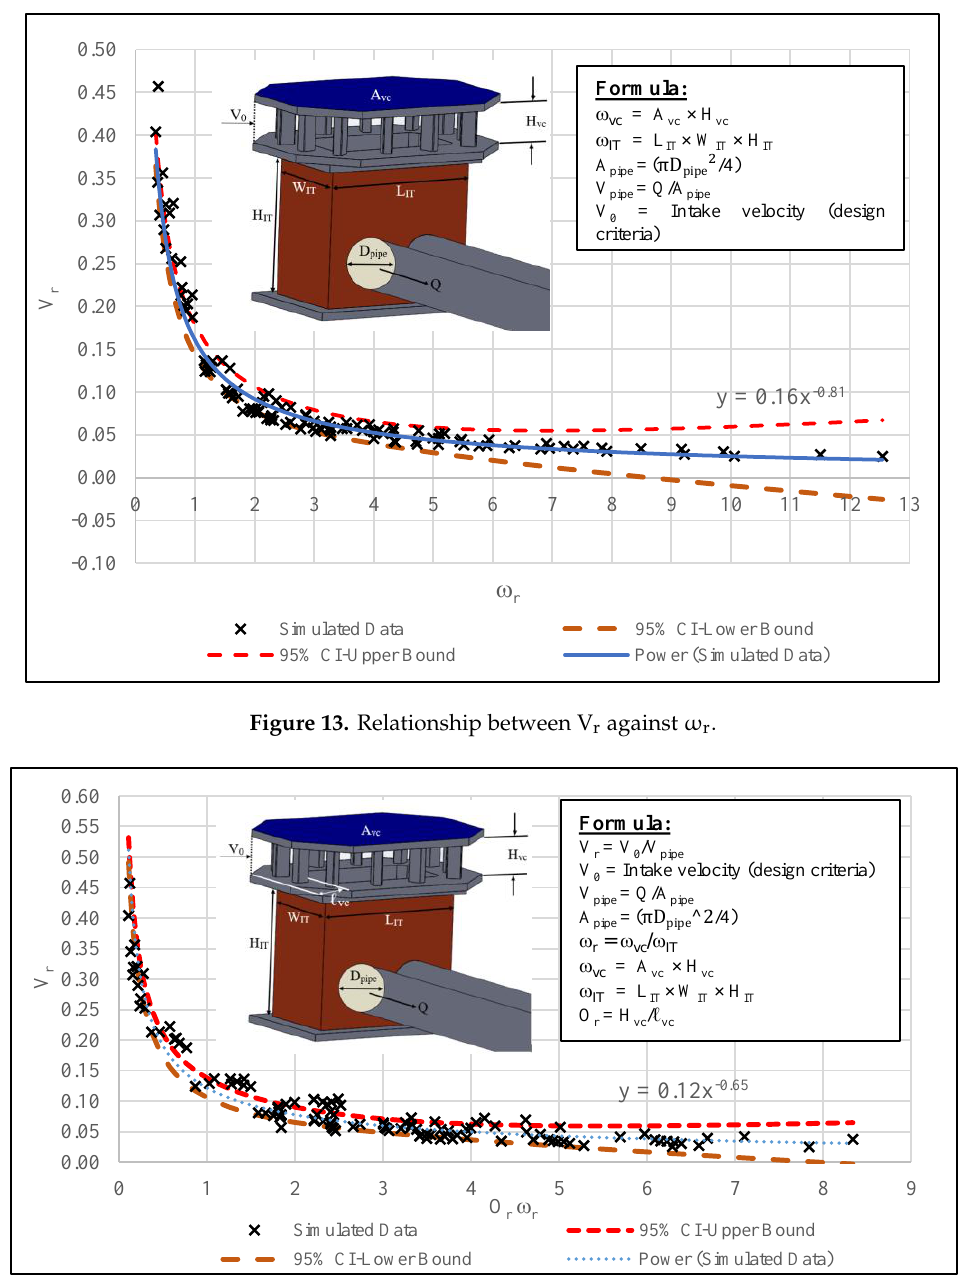
Figure 14. Relationship between V r against O r ω r. Table 4. Engineering design criteria for seawater intake structure.